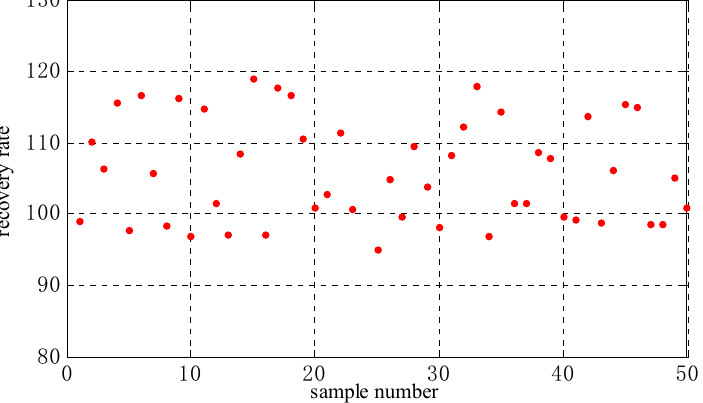
Figure 13. The recovery rate of GA-SVM.